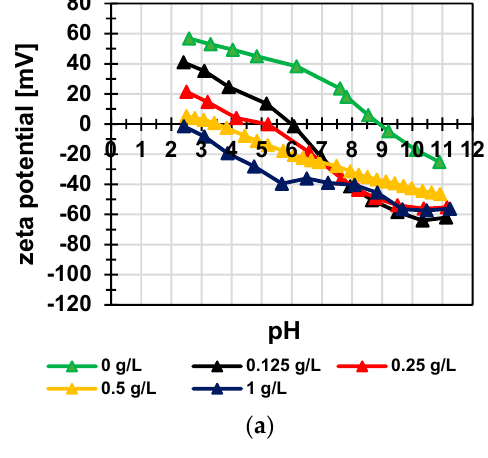
Figure 6. ( a ) Zeta potential as function of pH value; ( b ) IR spectra; membranes coated with 0.5 g/L PEI and variable PSSA content.